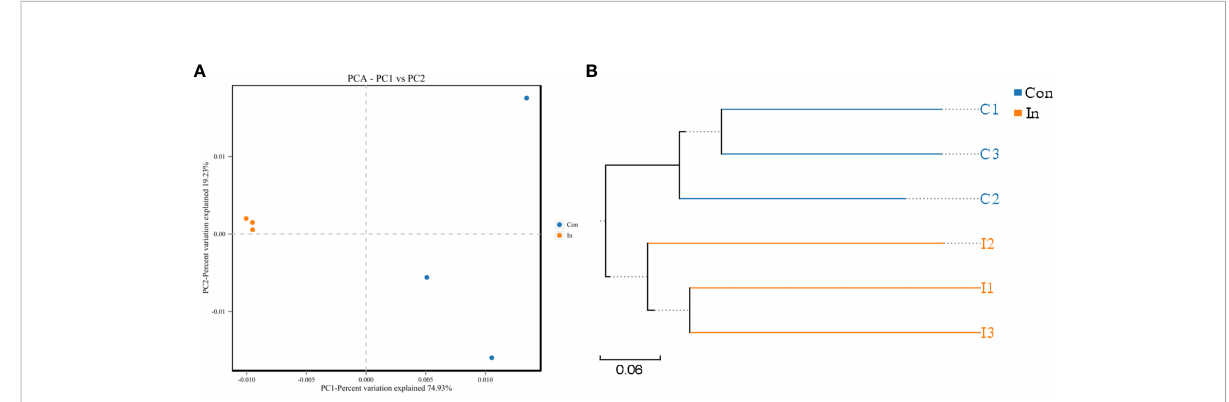
FIGURE 5 The PCA and phylogenetic analyses of intestinal microbiota of largemouth bass following MSRV infection. (A) PCA plot of intestinal bacterial communities between the infection and control group. (B) UPGMA tree based on weighted UniFrac distances. The Con means control group; In means infection group.